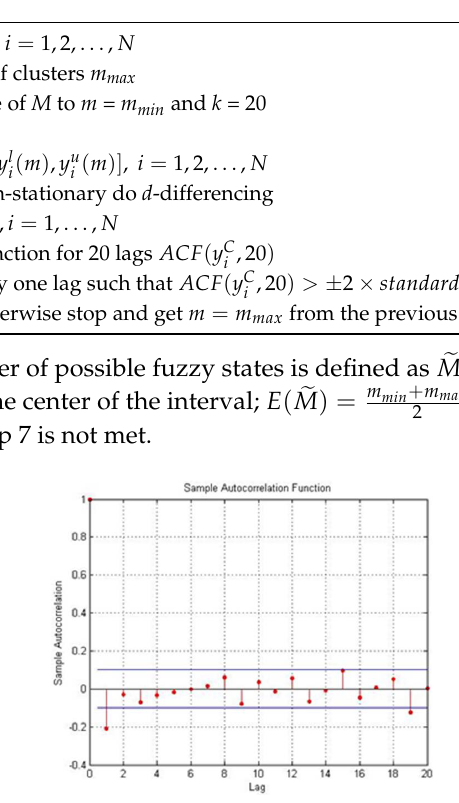
Figure 2. Autocorrelation function that does not satisfy the conditions.